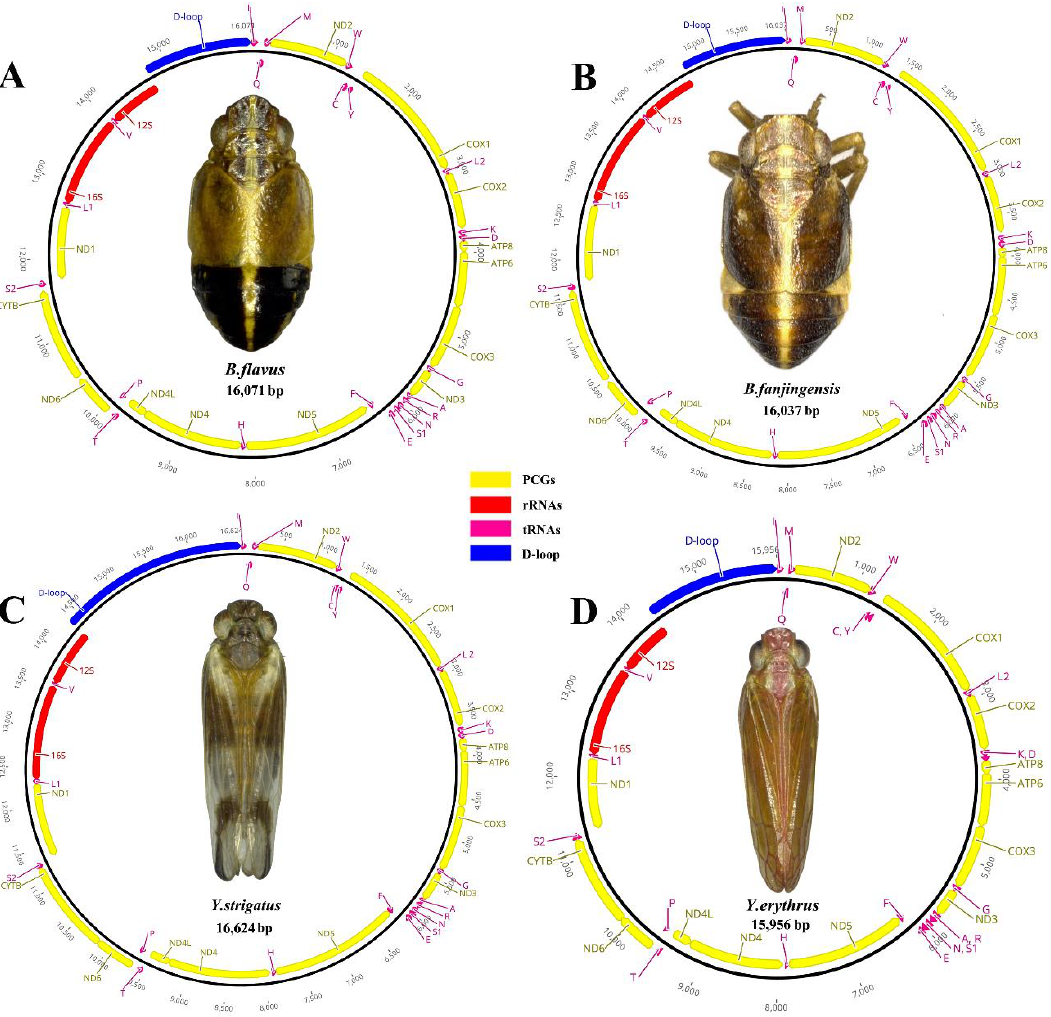
Figure 1. Circular maps of the mitogenomes of Bambusicaliscelis flavus ( A ), B. fanjingensis ( B ), Youtuus strigatus ( C ), and Y. erythrus ( D ). Protein-coding, ribosomal, and transfer RNA genes are shown with standard abbreviations. Gene orientations are indicated by arrow directions. Protein-coding genes are denoted in yellow, transfer RNA genes in aubergine, the AT-rich region in blue, and the two ribosomal RNA genes in red. The PCGs and rRNAs are the standard abbreviations. Each tRNA is denoted as a one-letter symbol according to the IUPAC-IUB single-letter amino acid codes.